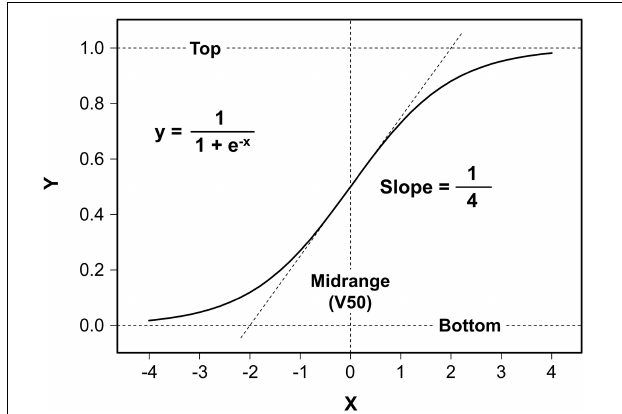
FIGURE 1 | Logistic function. The logistic function (without any parameters) represents the prototype of widely used functions for sigmoidal curve fitting to appropriate classes of two-dimensional experimental data. The graph has four characteristic values: Bottom = 0.0, Top = 1.0, maximum Slope = 0.25 at Midrange = 0.0, which is the abscissa of the curve’s central inflection